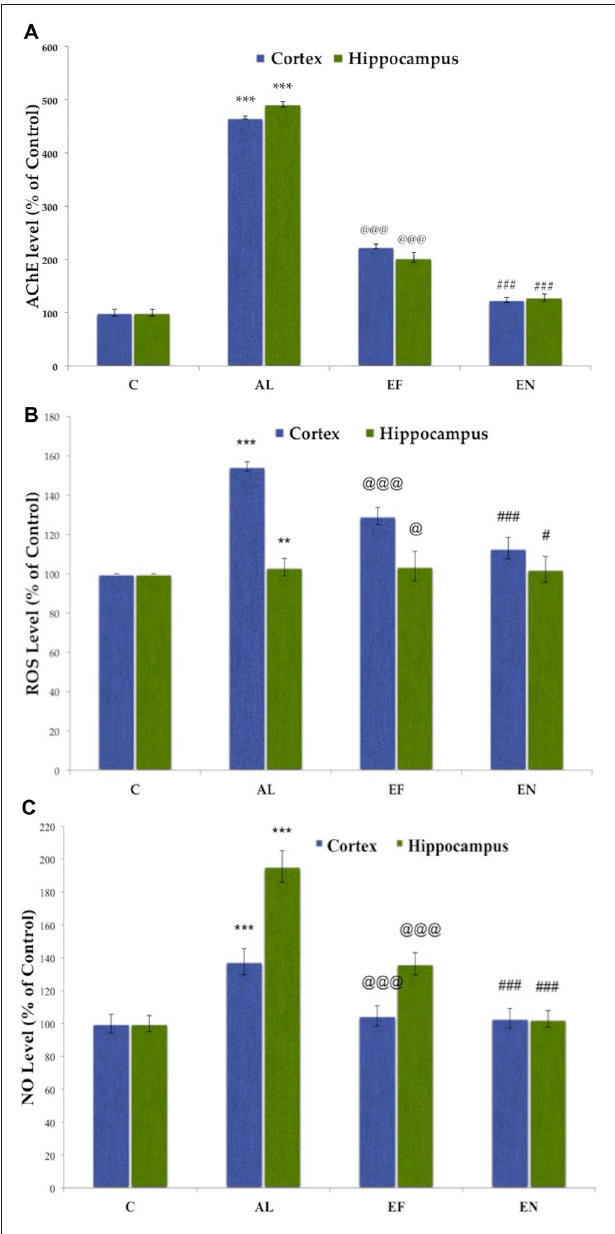
FIGURE 6 | Effect of AlCl 3 induction, free EGCG and nanoEGCG treatment on (A) Acetylcholinesterase activity, (B) Reactive oxygen species (ROS) generation and (C) Nitric oxide (NO) generation. Abbreviations: C, control; AL, AlCl 3 induced Alzheimeric rats; EF, free EGCG treated AlCl 3 induced Alzheimeric rats; EN, nanoEGCG treated AlCl 3 induced Alzheimeric rats. Significance difference between groups indicated by: ∗ between C and AL, @ between AL and EF and # between AL and EN. Significance levels of p < 0.001, p < 0.01 or p < 0.05 are denoted by repetition of these symbols.